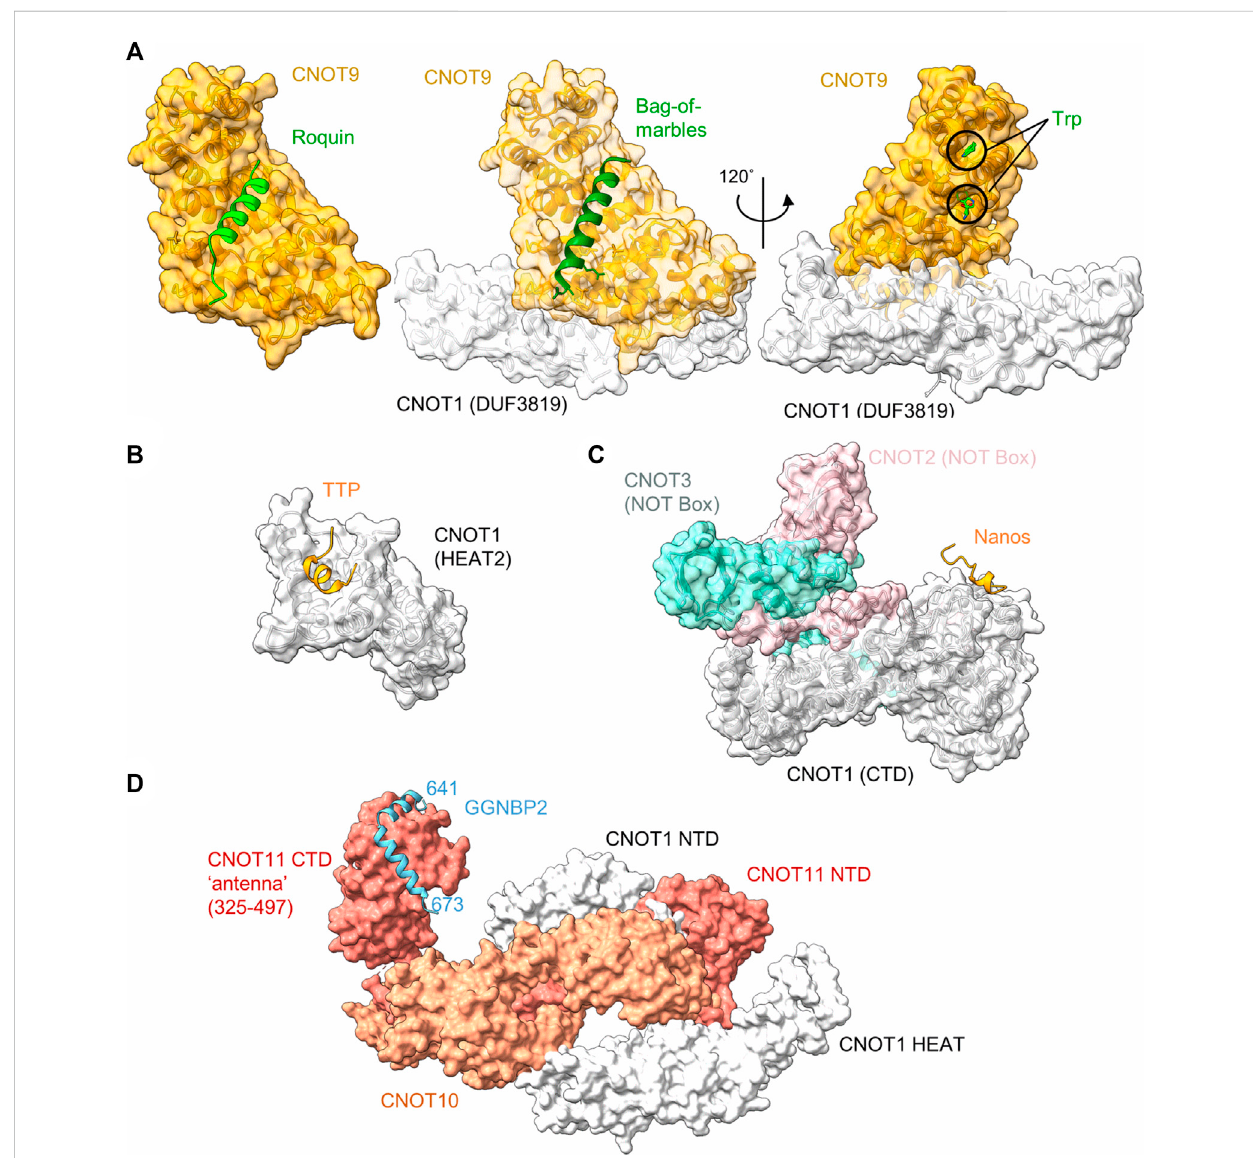
FIGURE 3 Recruitment of Ccr4-Not by regulators of mRNA stability. (A) Interaction of peptide motifs recognised by the CNOT9 (CAF40) subunit. Left panel , Drosophila CAF40 incomplexwithapeptide oftheRNA-binding proteinRoquin.PDBentry: 5LSW(Sgromoetal.,2017). Middlepanel , Drosophila NOT1- CAF40 in complex with a peptide from the RNA binding protein Bag-of-Marbles. PDB entry: 5ONA (Sgromo et al., 2018). Right panel , Human CNOT1- CNOT9 in complex with two tryptophan residues. PDB entry: 4CRV (Chen et al., 2014) or 4 − ΔΔ CT 7 (Mathys et al., 2014). (B) Interaction of a peptide from the RNA-binding protein Nanos in complex with C-terminal domain (CTD) of human CNOT1 (PDB entry: 4CQO) (Bhandari et al., 2014). The model includes the position of the NOT-Box regions of CNOT2 and CNOT3 obtained by superposition of PDB entry 4C0D (Boland et al., 2013). (C) Binding of a TTP peptide to a MIF4G-like domain of CNOT1. PDB entry: 4J8S (Fabian et al., 2013). (D) Model of the N-terminal module in complex with a fragment of GGNBP2. The model was created by superimposing PDB entries 8BFI and 8BFJ (Mauxion et al.,